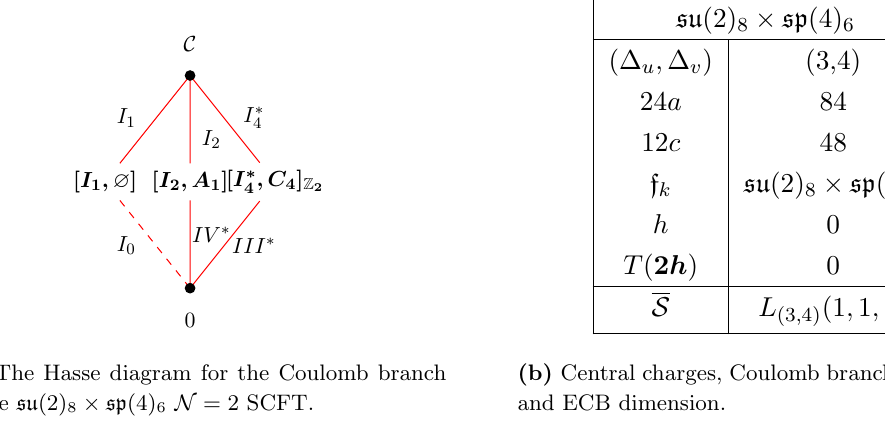
Figure 18. Information about the su (2) 8 (cid:2) sp (4) 6 N = 2 SCFT.